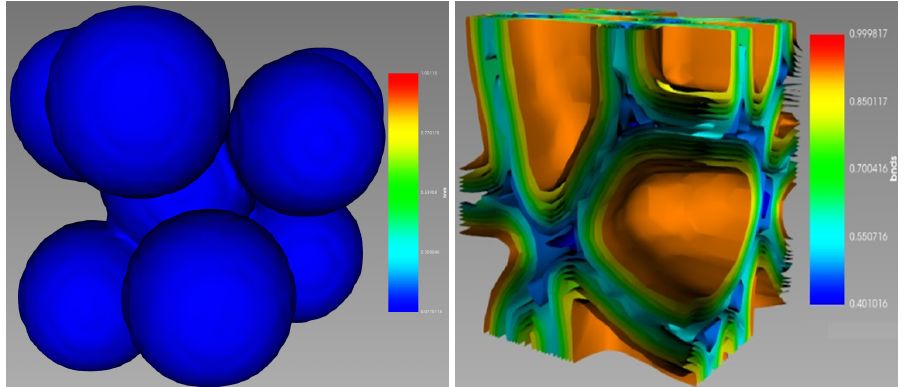
Figure 6. Results of the phase-field simulations of the microstructure evolution in 3D solid state sintering: ( left ) at initial time and ( right ) cross-sectional view after 24 time units.